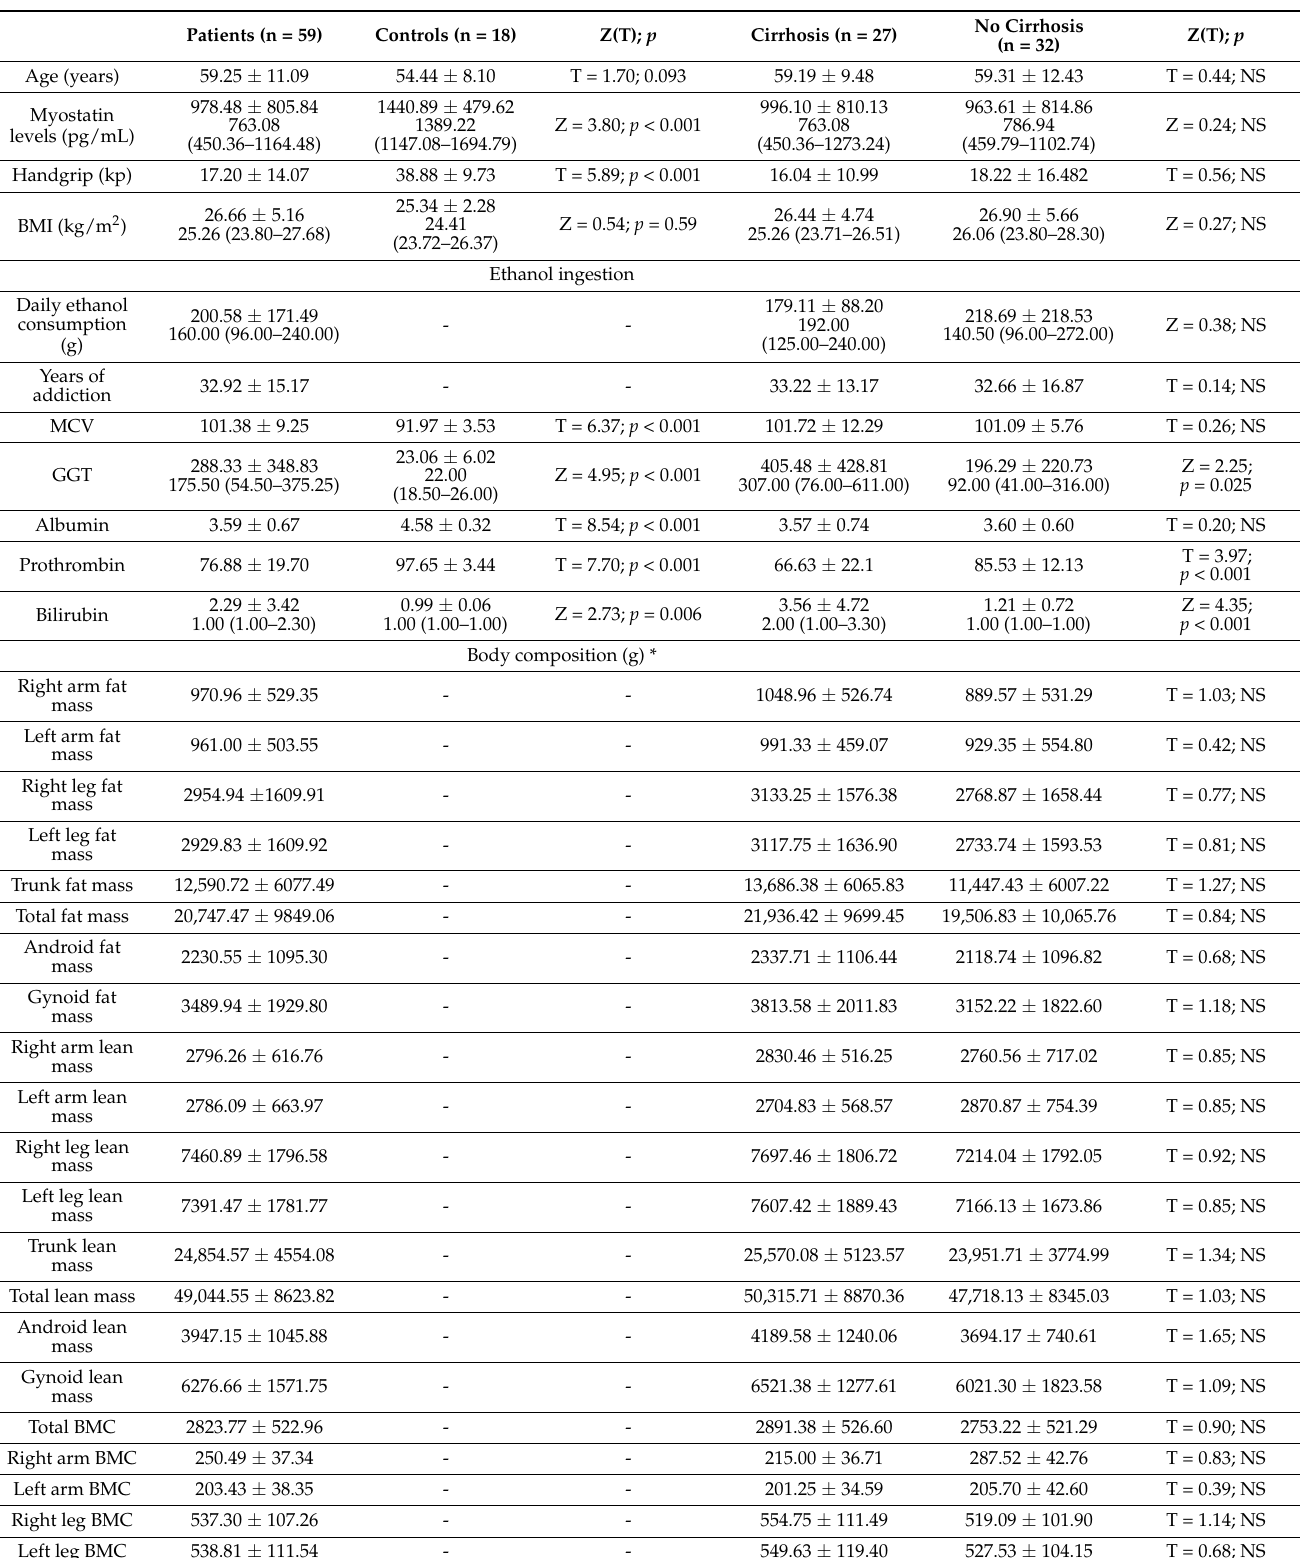
Table 1. Some biological differences among patients and controls and among patients with and without